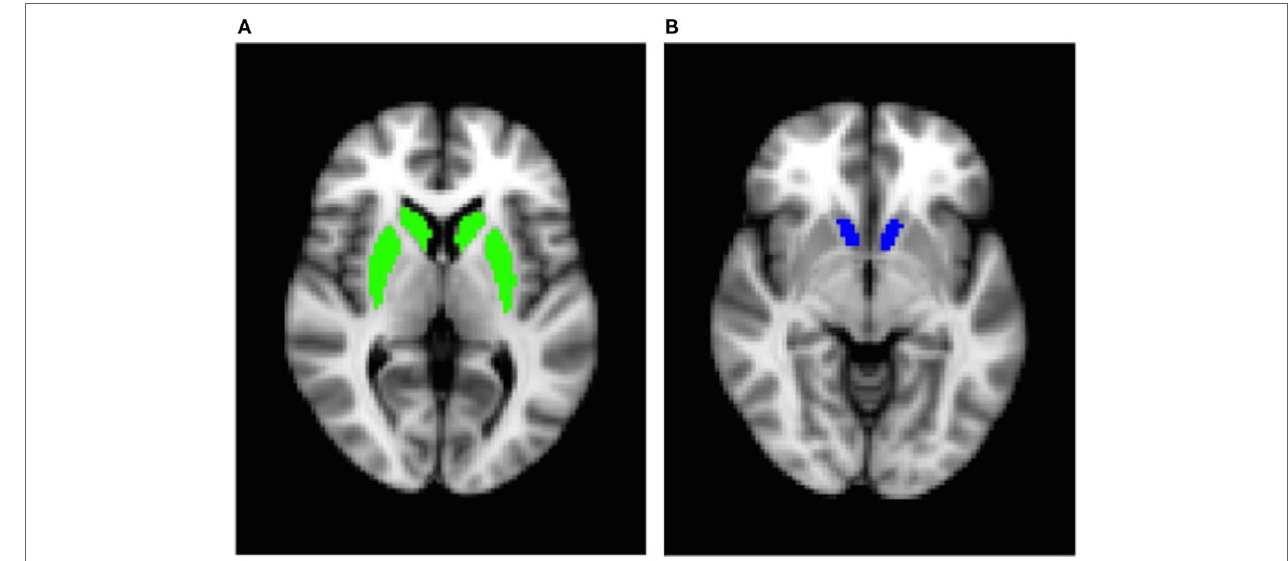
FigUre 1 | Bilateral region-of-interest masks: (a) dorsal striatum (caudate/putamen) and (b) nucleus